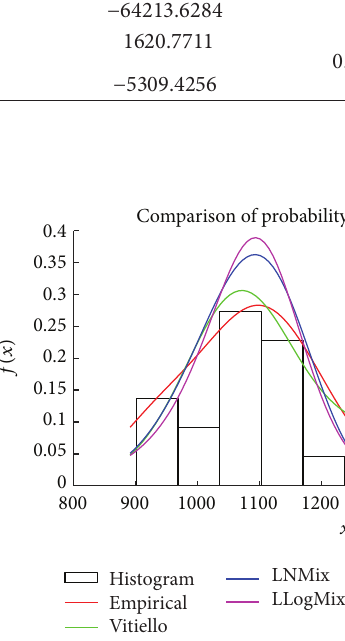
𝑔 densities estimated from